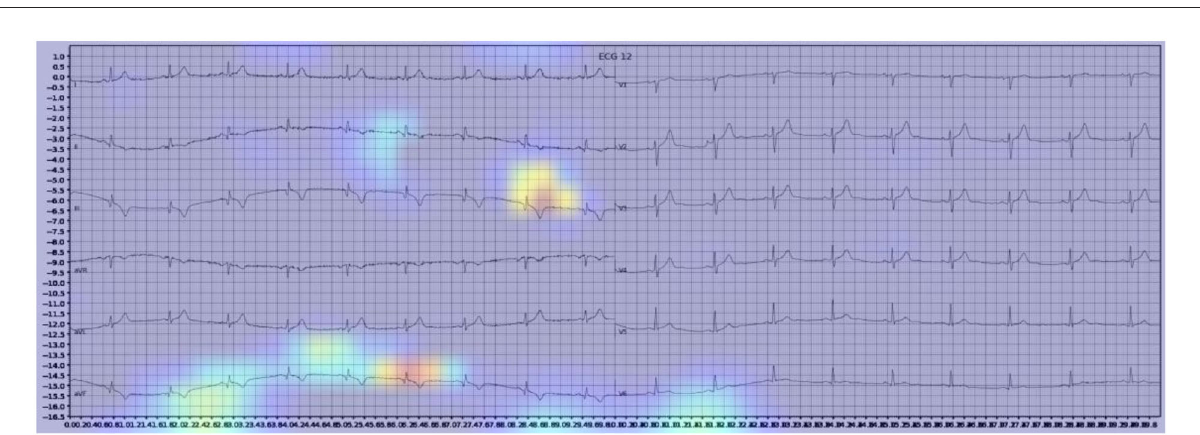
FIGURE4 Example of an activation heatmap for an ECG showing myocardial